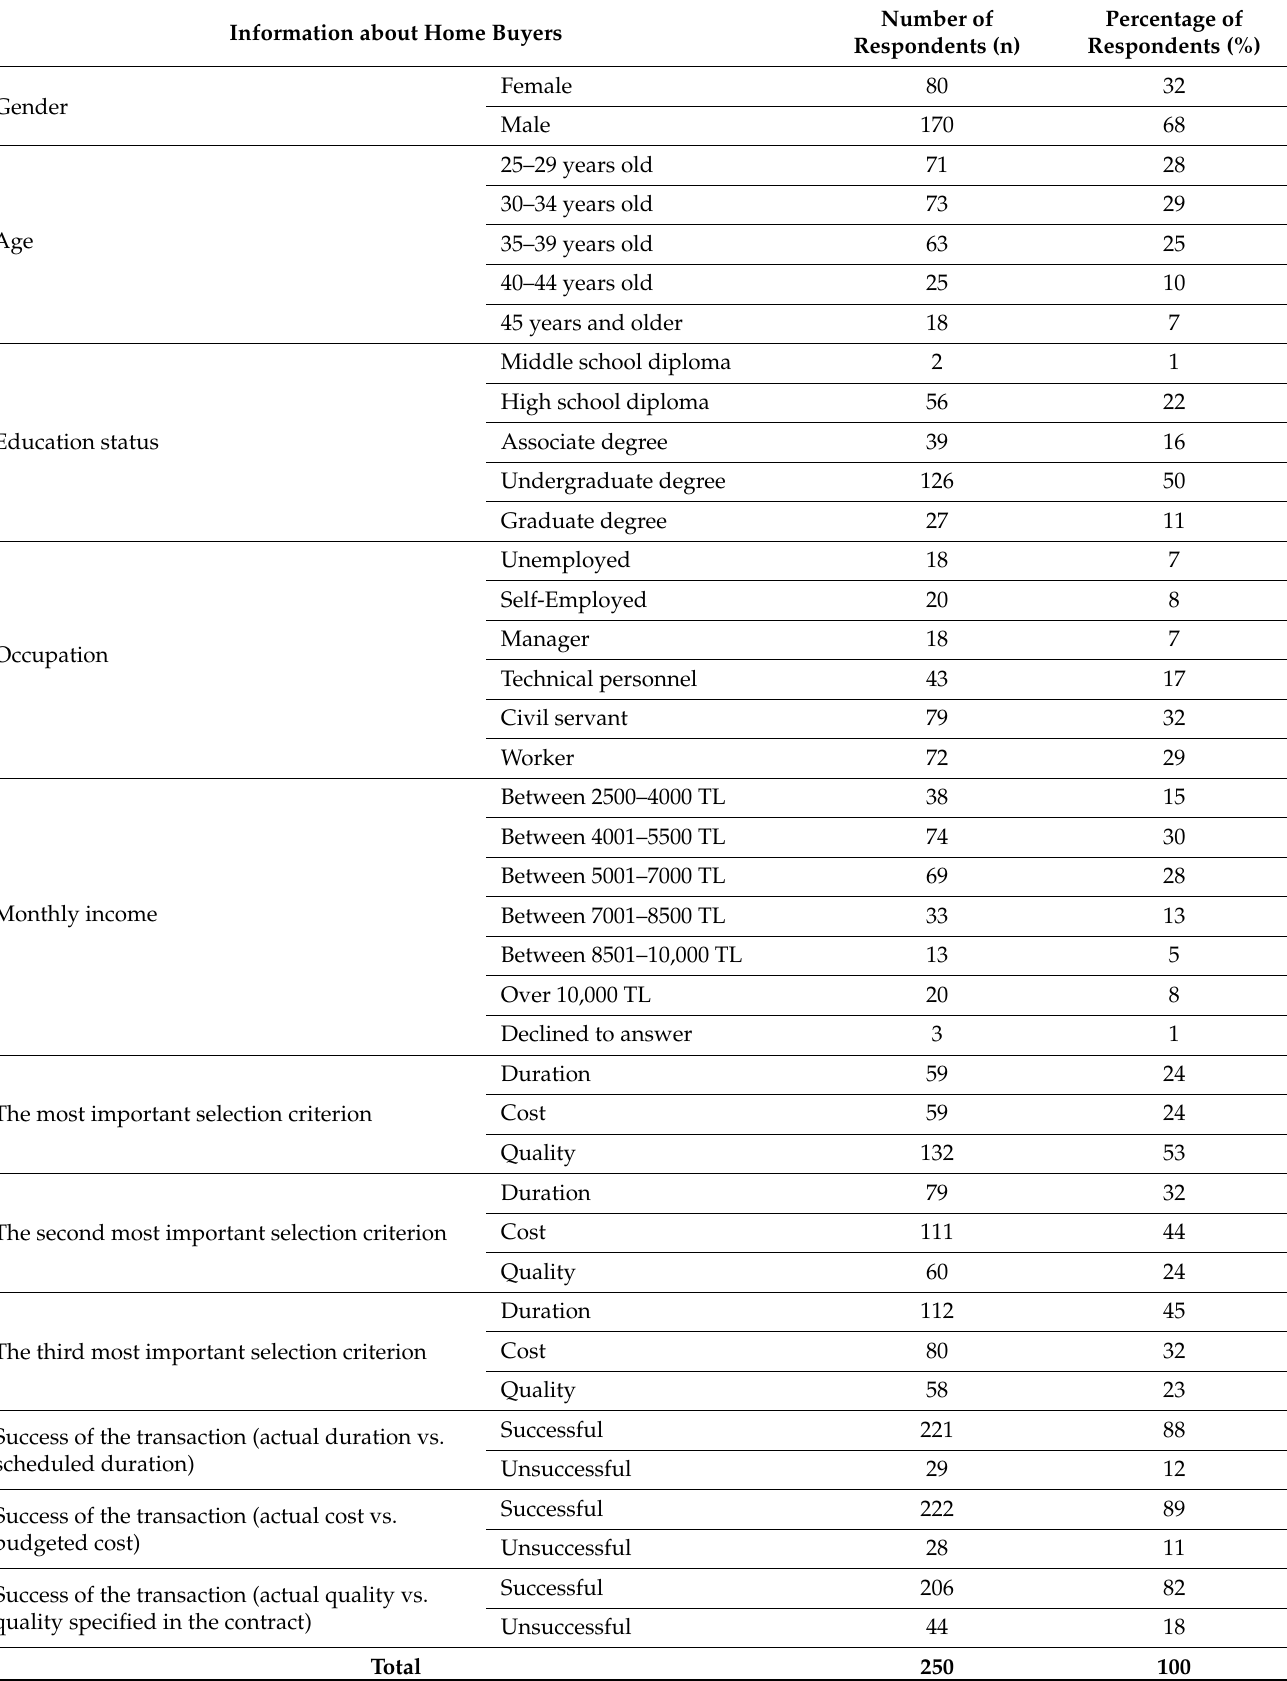
Table 4. Distribution of responding home buyers by their demographic